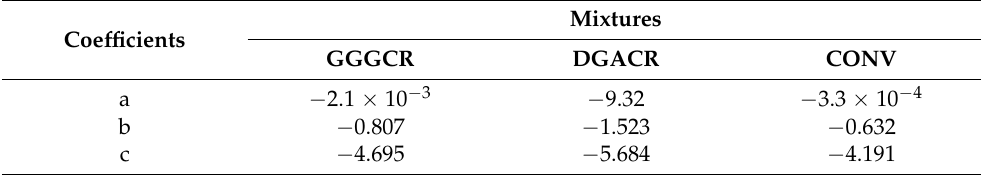
Table 7. Fatigue law parameters (Equation (5)) taking the temperature into